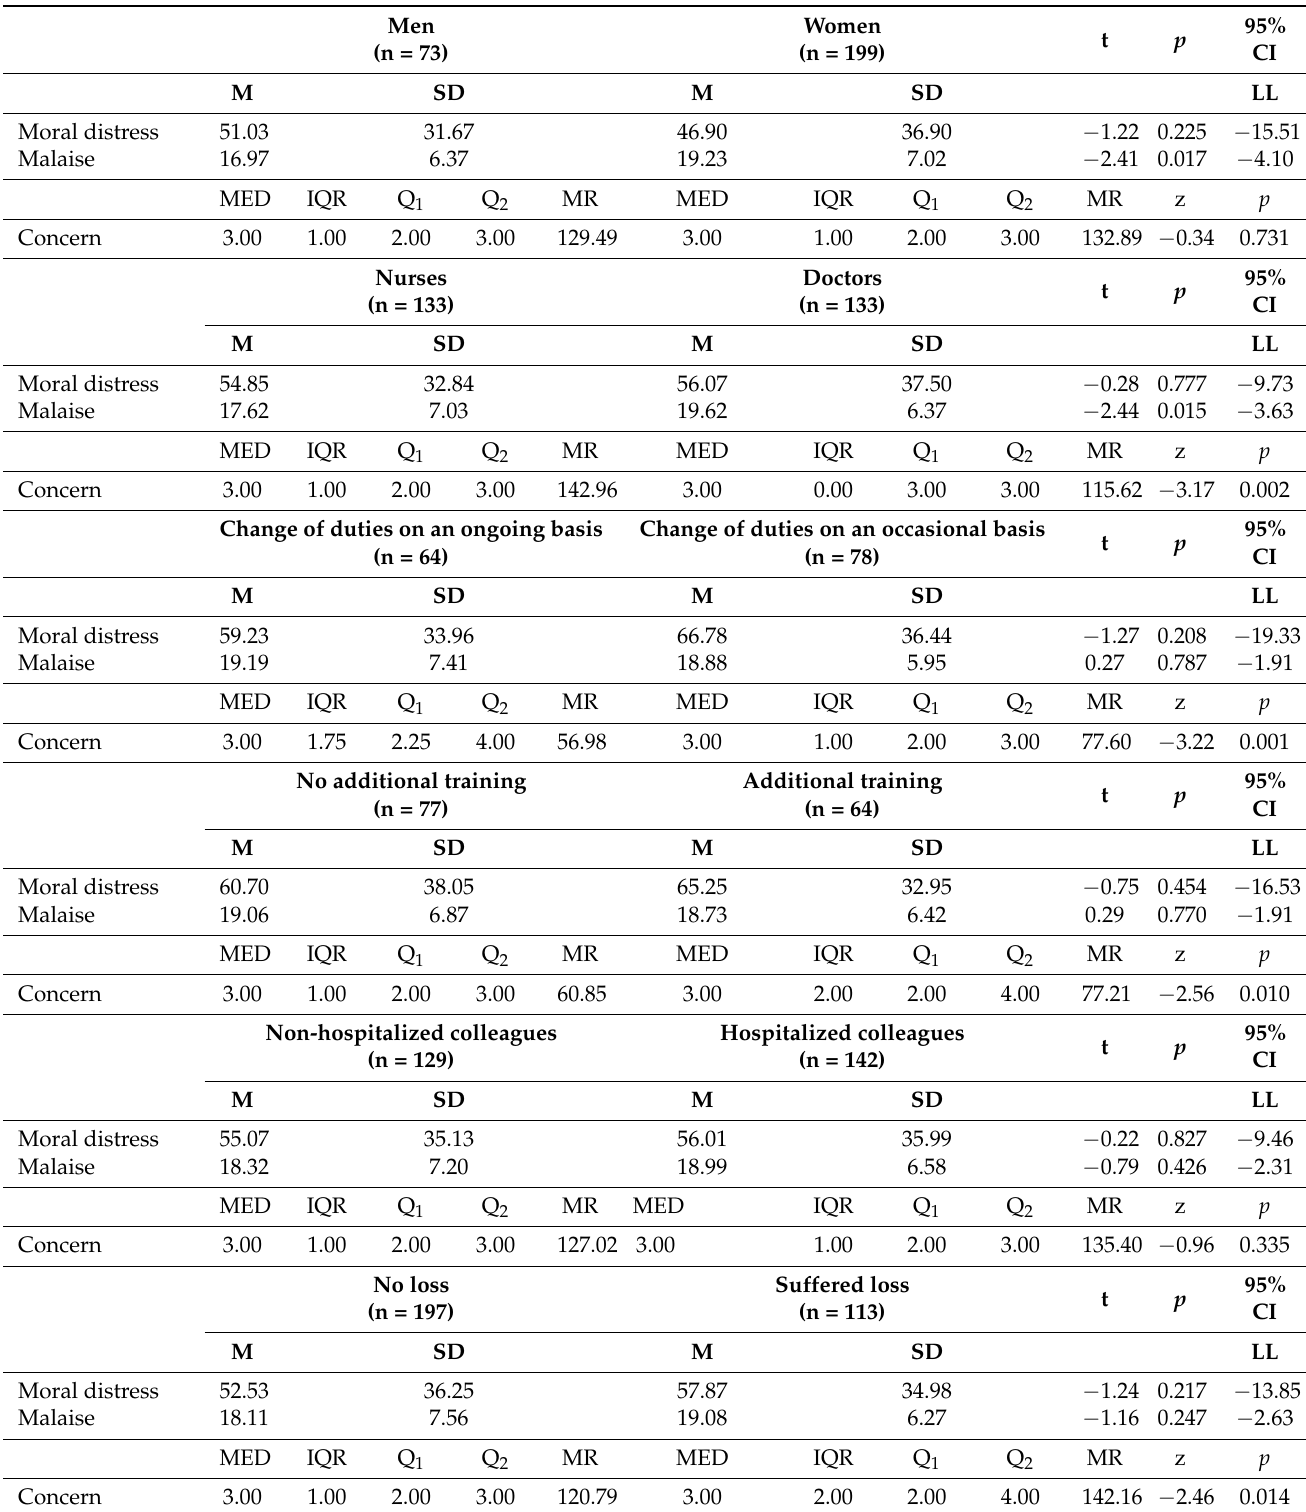
Table 5. Results of the independent t -test and Mann-Whitney test in relation to gender, profession, modalities of change of duties, receiving supplementary training for change in duties, having hospitalized colleagues, having suffered a